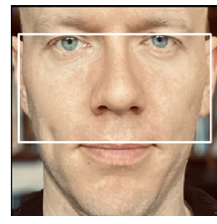
Figure 2. Illustration of